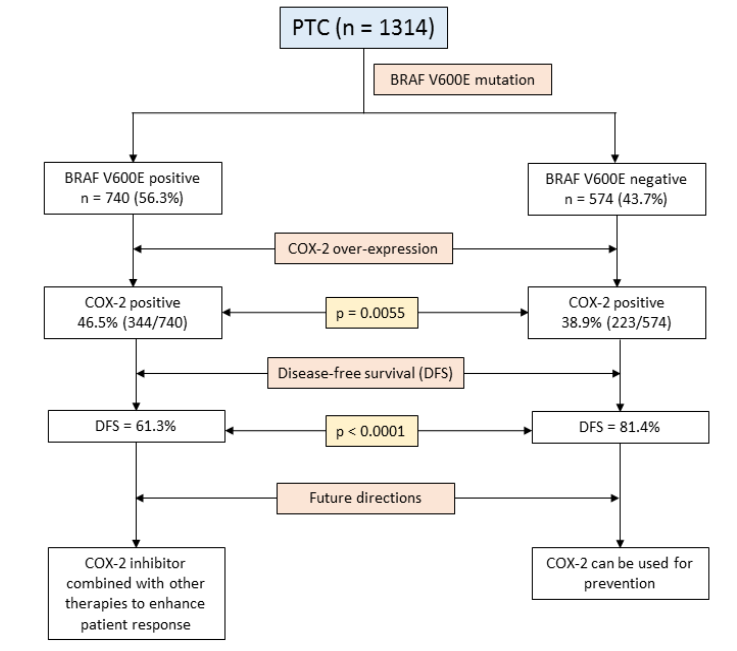
Figure 3. Schematic presentation of the study findings and future directions.